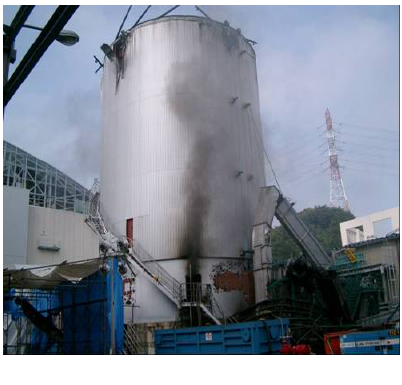
Figure 2. RDF silo explosion in August